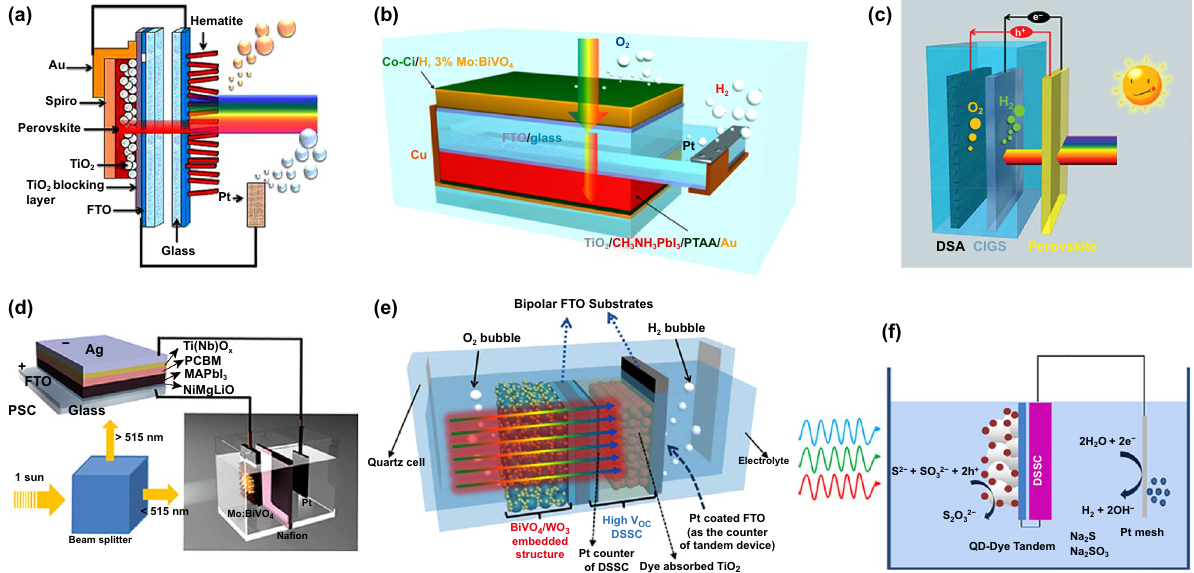
Fig. 8 a Schematic of the dual-junction PSC/hematite photoanode tandem cell. Reproduced with permission from Ref. [114]. Copyright 2015 American Chemical Society, b configuration consisted of Co–Ci/H, 3% Mo:BiVO 4 and TiO 2 /CH 3 NH 3 PbI 3 tandem cell. Reproduced with per- mission from Ref. [115]. Copyright 2015 American Chemical Society, c schematic of the perovskite and CIGS tandem water splitting cell. Reproduced with permission from Ref. [116]. Copyright 2015 John Wiley and Sons, d the configuration of the PEC-PSC tandem device. Repro- duced with permission from Ref. [117]. Copyright 2016 American Association for the Advancement of Science, e schematic of the WO 3 /BiVO 4 photoanode tandem configuration. Reproduced with permission from Ref. [120]. Copyright 2015 Elsevier Inc., f scheme of the PEC-DSSC tan- dem cell. Reproduced with permission from Ref. [121]. Copyright 2013 American Chemical